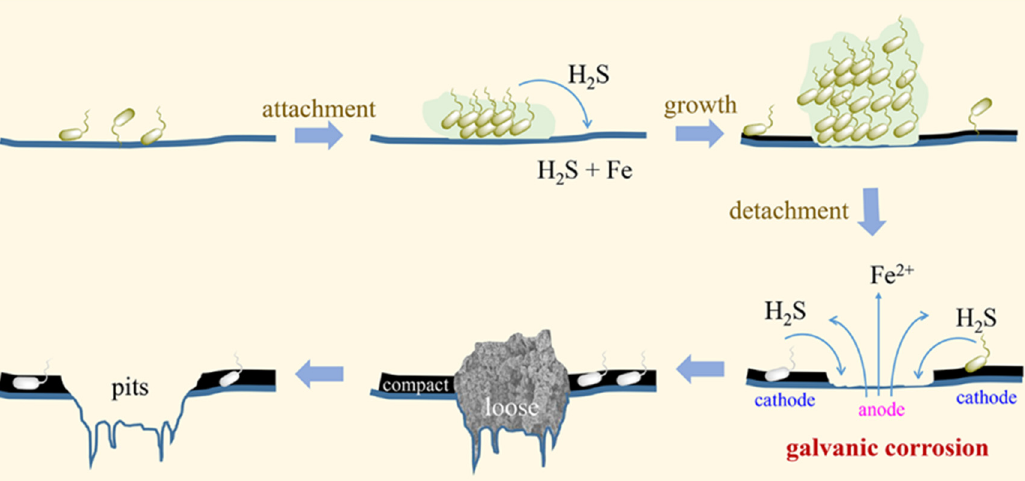
Figure 7. Schematic illustration of the corrosion behavior and mechanism of Q235 under the SRB-Z condition.